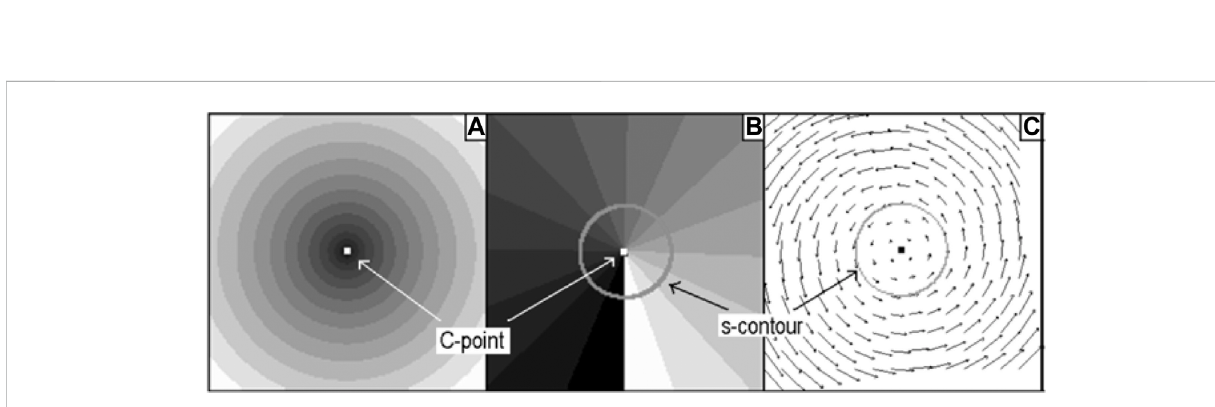
FIGURE 13 Spatial distribution of thetransverse Poynting vector U ⊥ Eq. 5.6 for the symmetric fi eld ofEqs5.11, 5.12: (A) distributionof the modulus | U ⊥ |,brighter colorsdenotehighervalues; (B) distributionofthevectorazimuth,fromwhite( ϕ =0)toblack( ϕ =2 π ); (C) explicitvector- fi eldpattern(localdirectionsand strengths are indicated by the orientations and lengths of the